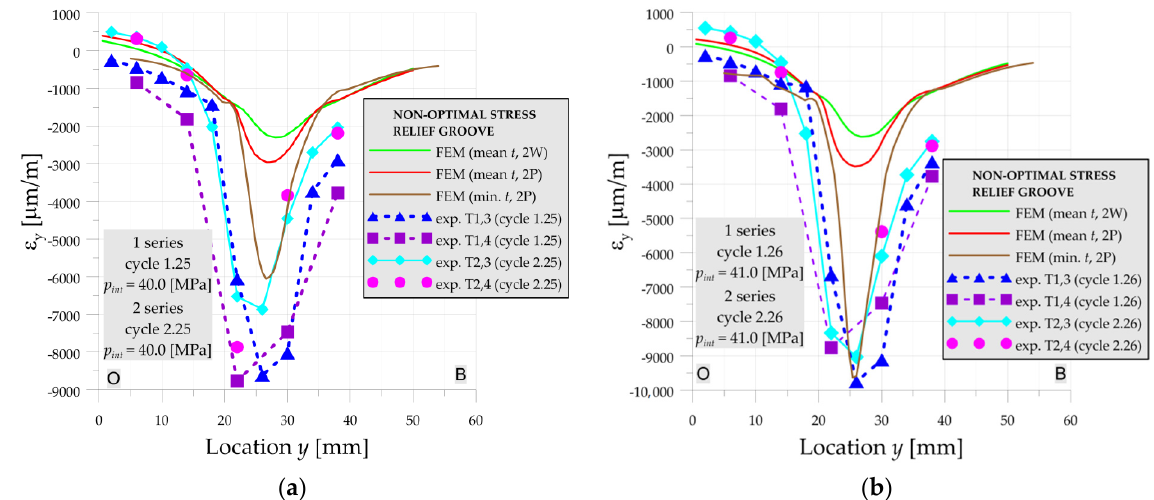
Figure 14. Numerical and experimental strains on line O-B, non-optimal SRG, 1st and 2nd series: ( a ) cycles 25; ( b ) cycle 26.